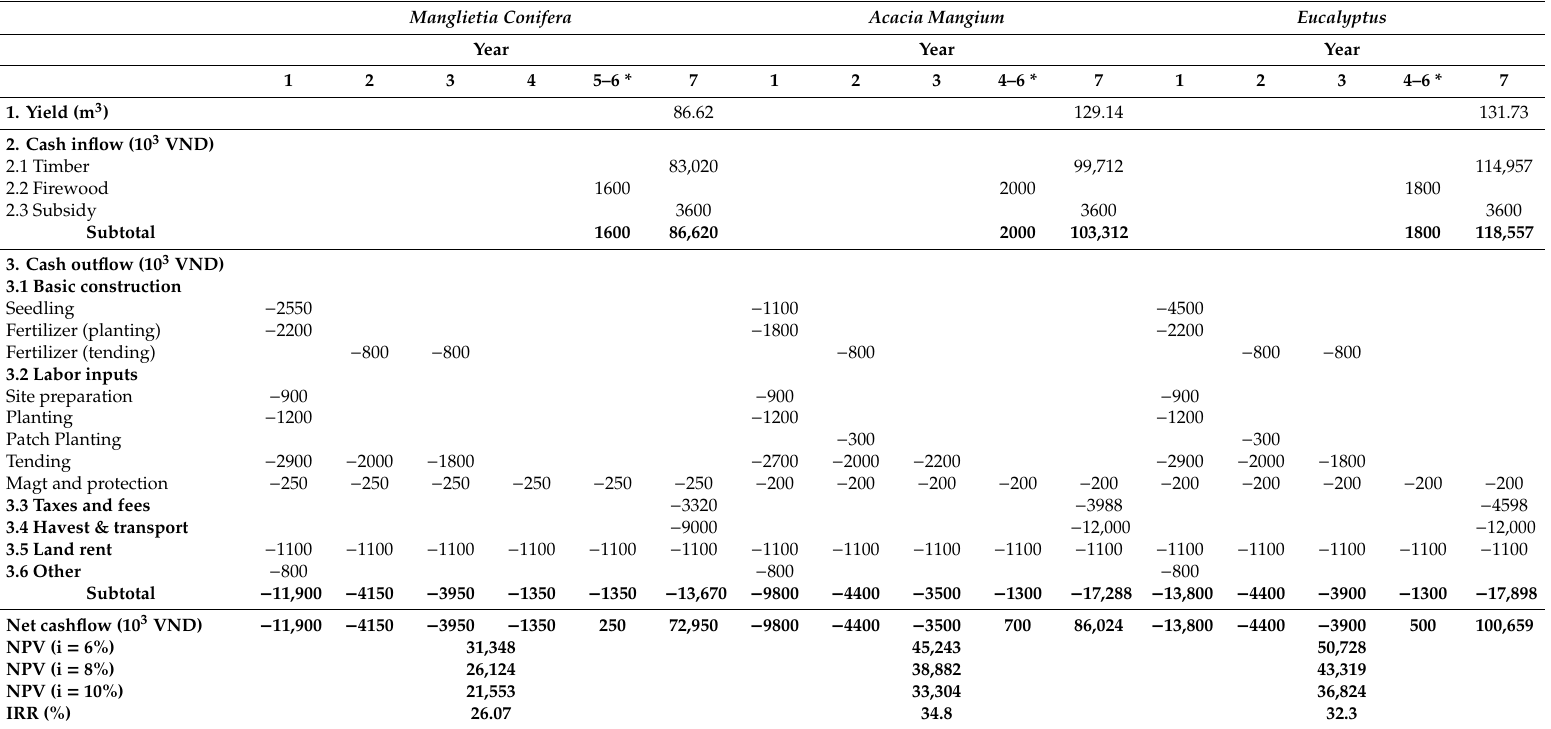
Table 3. Cashflow for the forest plantation of three